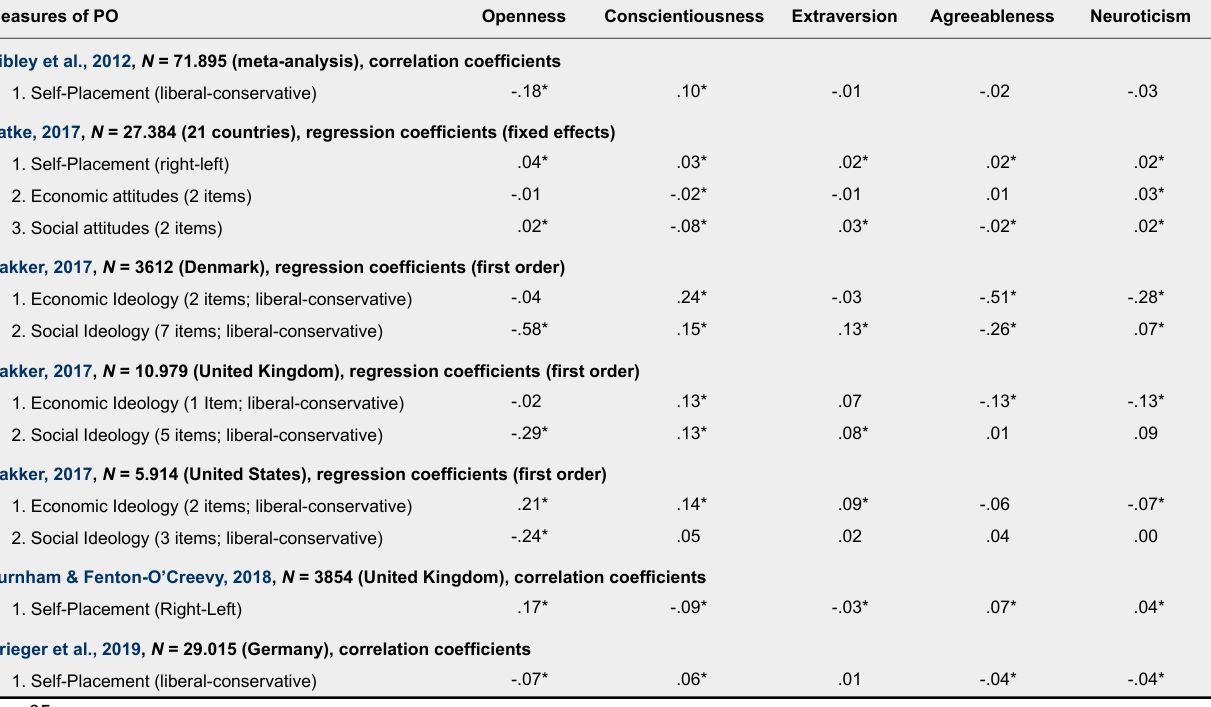
Prior Studies on the Relationship Between Personality and Political Orientation NeuroticismAgreeablenessExtraversionConscientiousnessOpennessMeasures of PO Sibley et al., 2012, N = 71.895 (meta-analysis), correlation